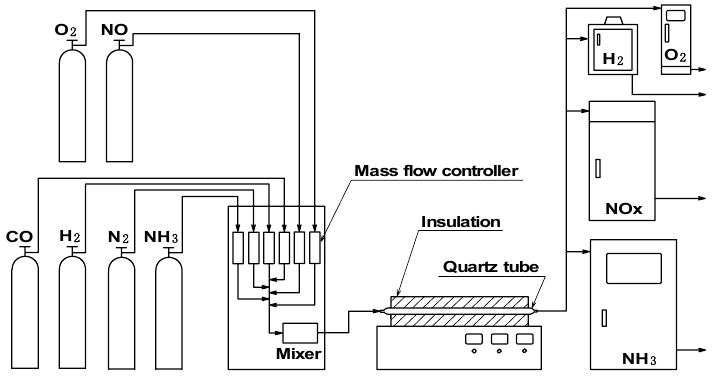
Figure 26. Schematic diagram of experimental apparatus designed to yield homogeneous